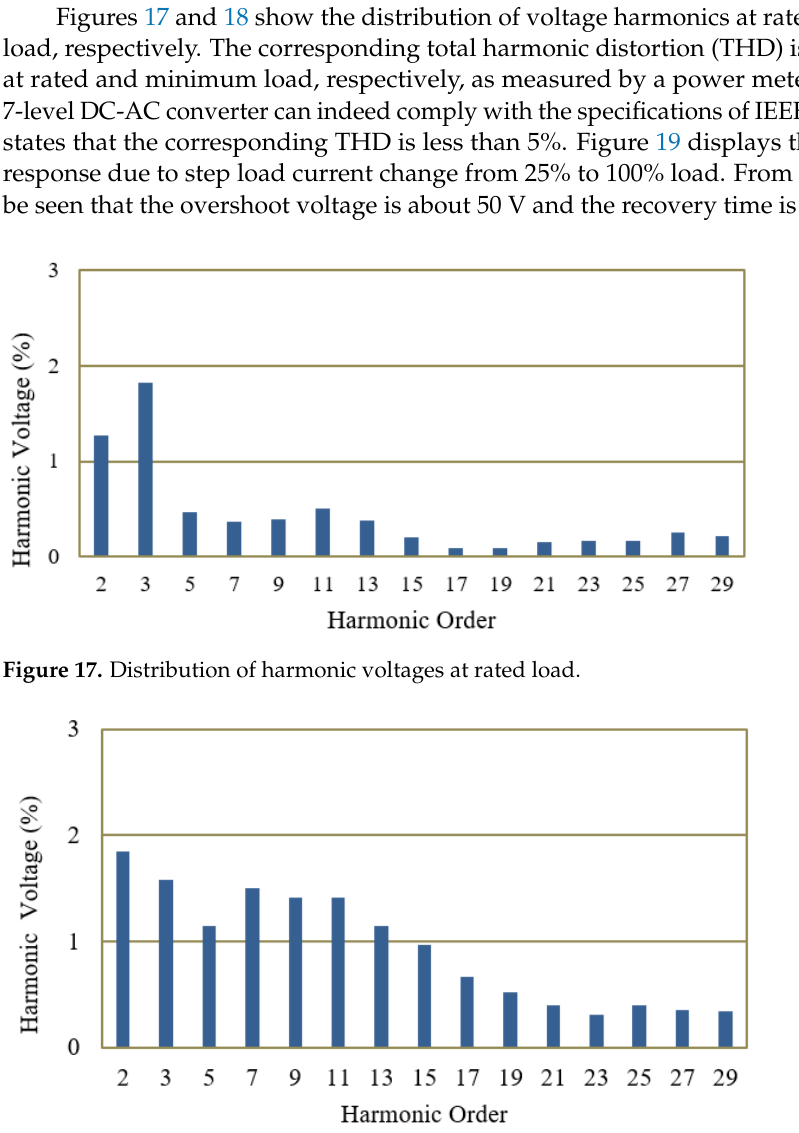
Figure 18. Distribution of harmonic voltages at minimum load.